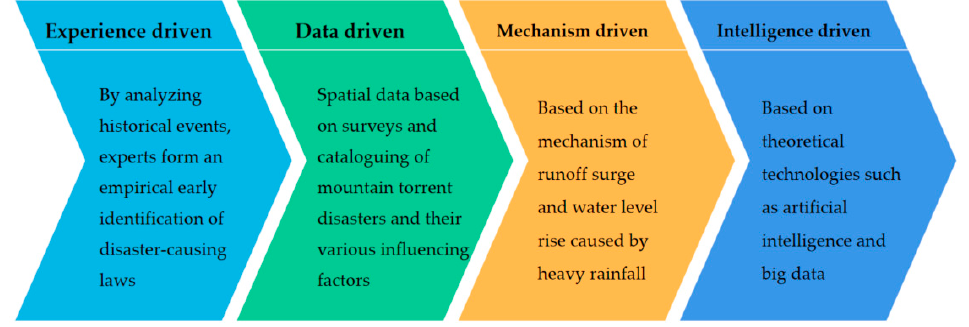
Figure 16. Sensitivity analysis and mapping methods.